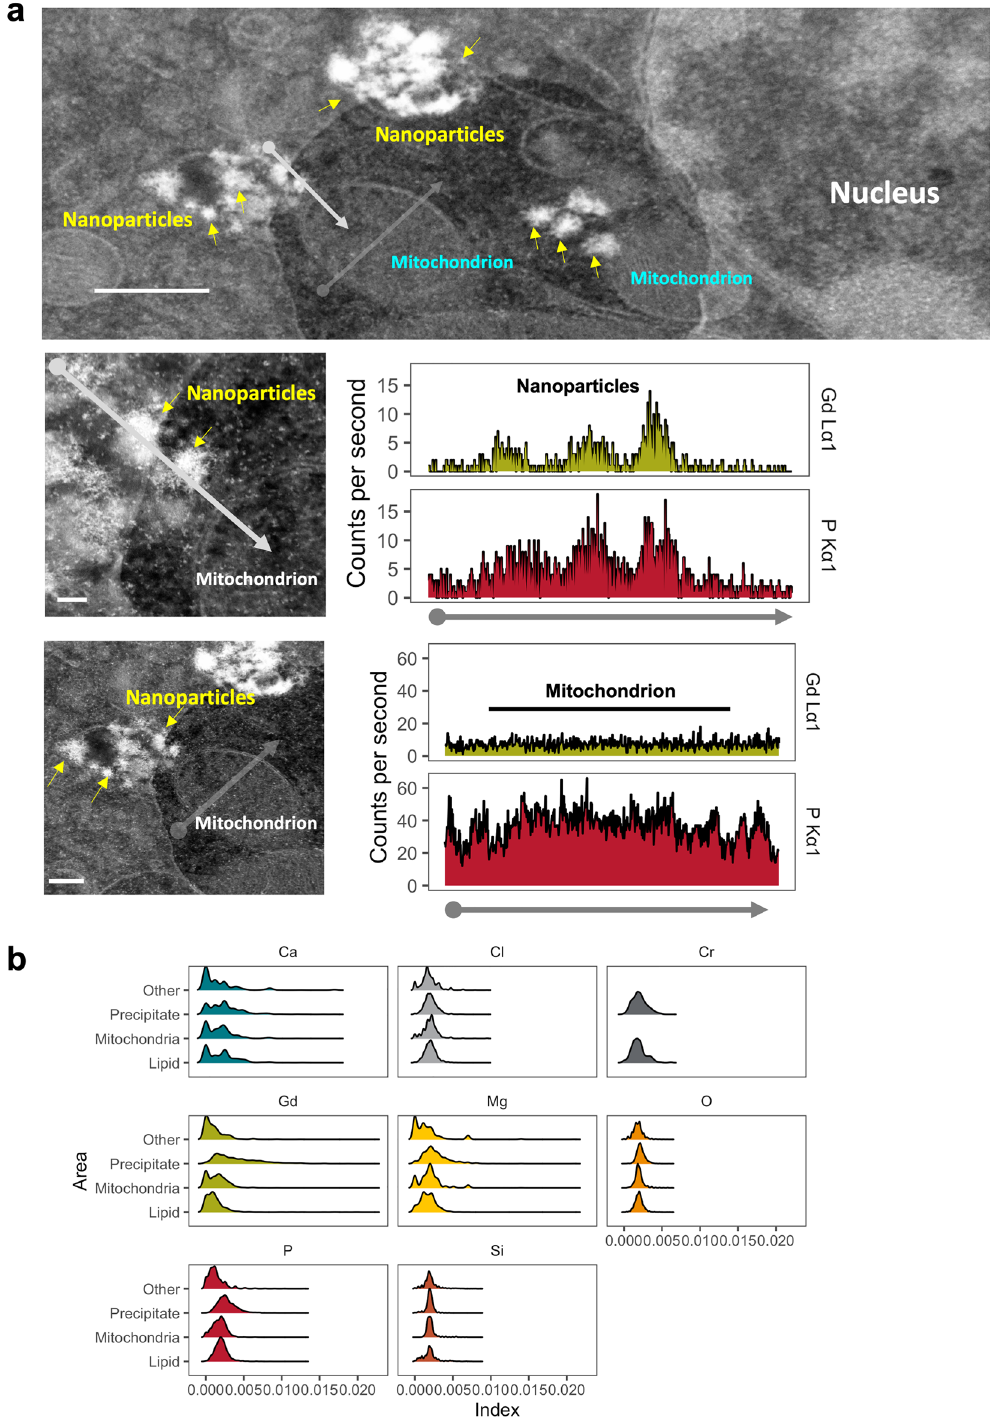
Figure 4. Elemental composition of nanoparticles differs from other subcellular regions. Renal cortex from a MRI contrast- agent treated mouse was analyzed by darkfield STEM. ( a ) (Top panel) Clusters of electron-dense precipitates identified in an epithelial cell from kidney cortex of a MRI contrast agent-treated male mouse. The numerous mitochondria and ellipsoid nucleus suggest a proximal tubular cell. Bar = 0.5 µm. (Middle panel) XEDS line scan through several spiculated electron-dense nanoparticles and mitochondrion. Bar = 50 nm. The XEDS line scan data (X-ray intensity in counts per second vs distance) shows high levels of gadolinium and phosphorus corresponding with the line scan through the nanoparticles. (Lower panel) Mitochondria and cytoplasm do not show elevations in gadolinium. An XEDS line scan through a mitochondrion and cytoplasm (avoiding electron-dense precipitates). Calibration bar = 0.2 µm, JEOL 2010F FEGSTEM 200 kV transmission electron microscope, with Oxford Analytical AZTec XEDS system, equipped with XMax 80 N 80 mm 2 silicon drift detector. ( b ) Ridgeline plots for calcium (Ca), chlorine (Cl), chromium (Cr), gadolinium (Gd), magnesium (Mg), oxygen (O), phosphorus (P), and silicon (Si) in intracellular precipitates, unilamellar bodies/lipids, mitochondria, and other subcellular regions. The XEDS signals were indexed to the total areas under each